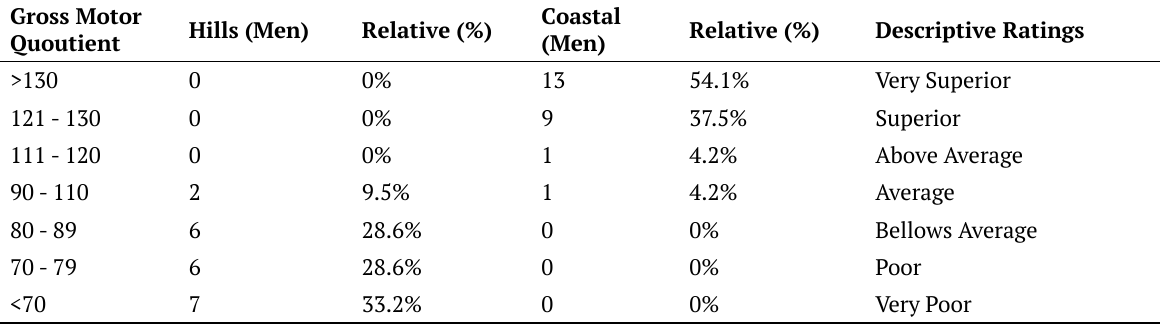
Table 5. Motoric Assessment of Lower Class Students in Hilly and Coastal